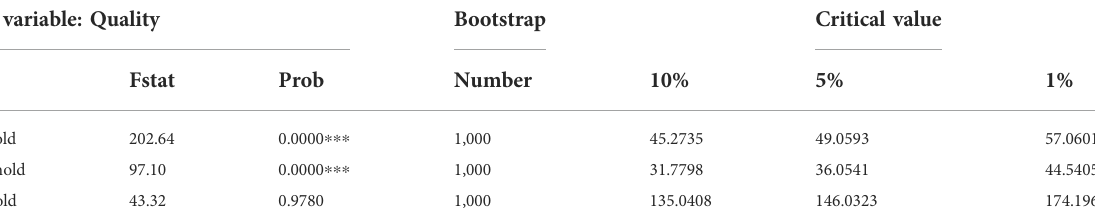
TABLE 9 Results of the threshold effect test.